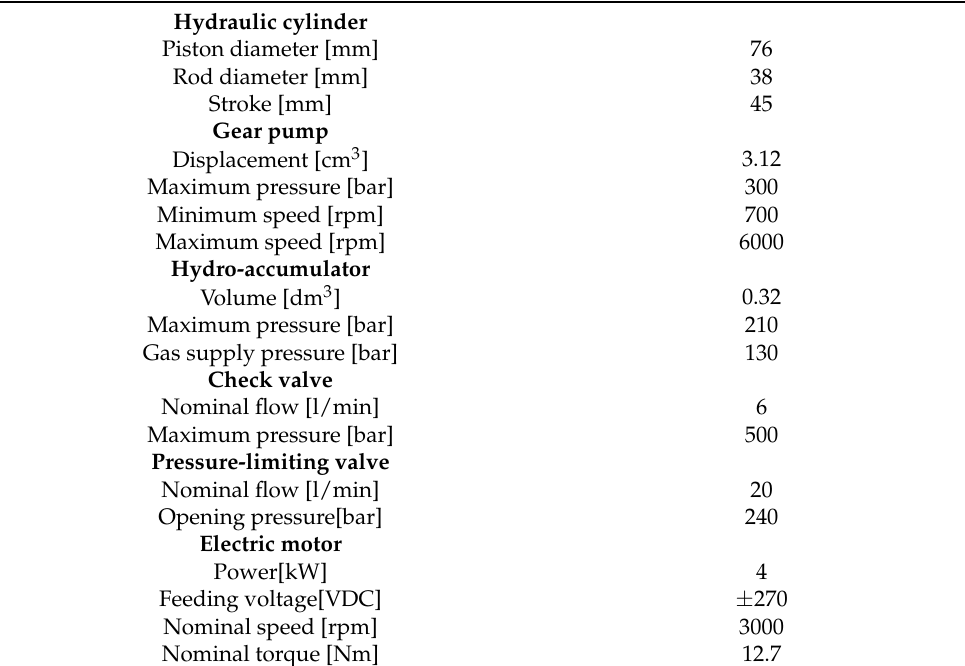
Table 2. Component characteristics.